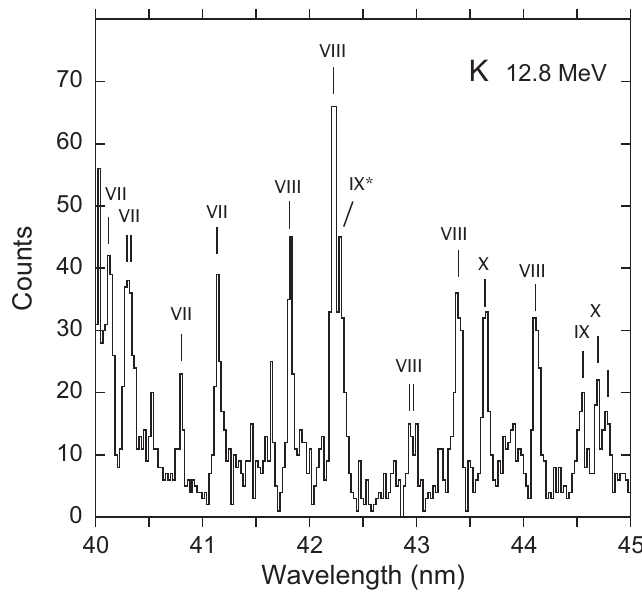
Figure 1. Beam-foil spectrum of 39 K recorded at an ion beam energy of 12.8MeV, close to the optimum ion beam energy for the production of the KIX spectrum [74]: Line width (full width at half maximum, FWHM) is 0.06nm. The more prominent lines are labeled by the spectrum number [75]. The KIX* line of interest is partly blended with a stronger line of